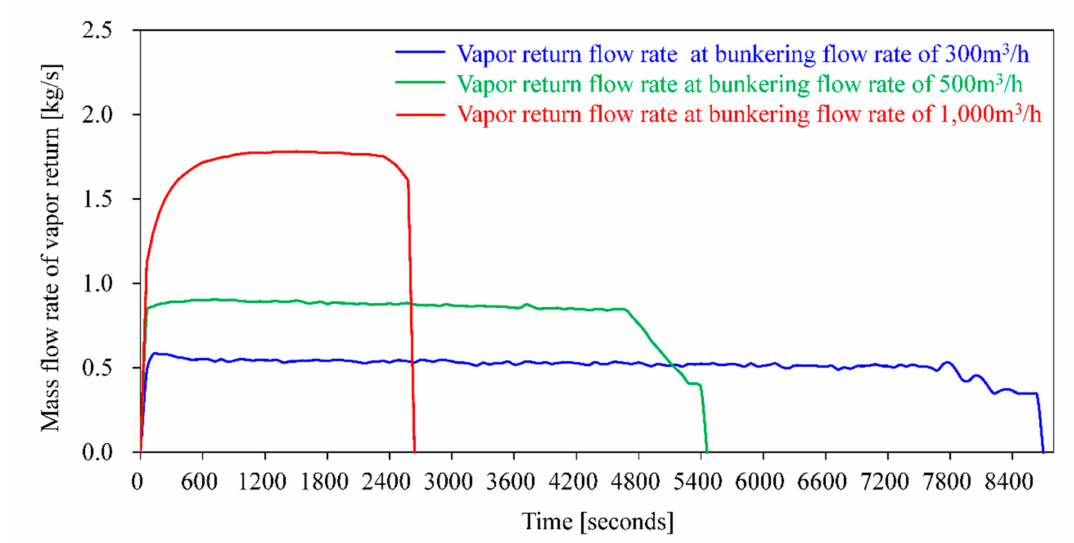
Figure 6. Variation of vapor return flow rates at bunkering flow rates of 300, 500, and 1000 m 3 /